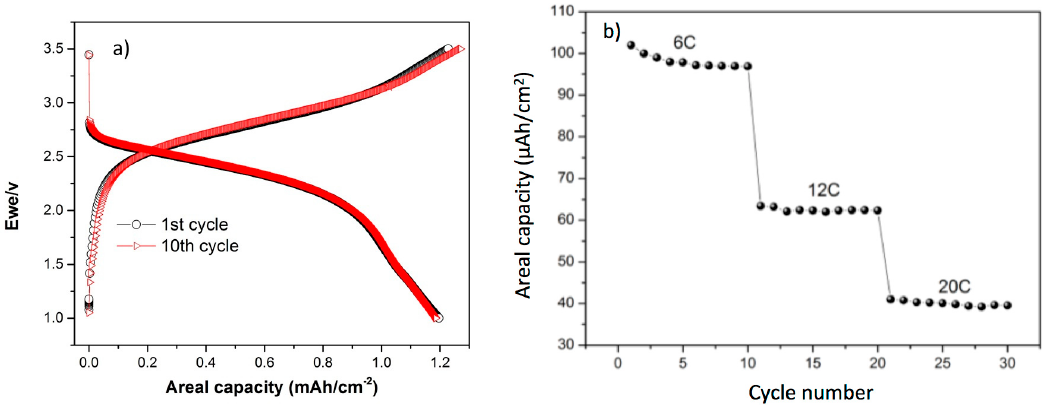
Figure 5. Galvanostatic charge / discharge profiles of LTO / Polymer / LNMO micro battery ( a ); discharge capacity of the micro battery at multi C-rates ( b ).